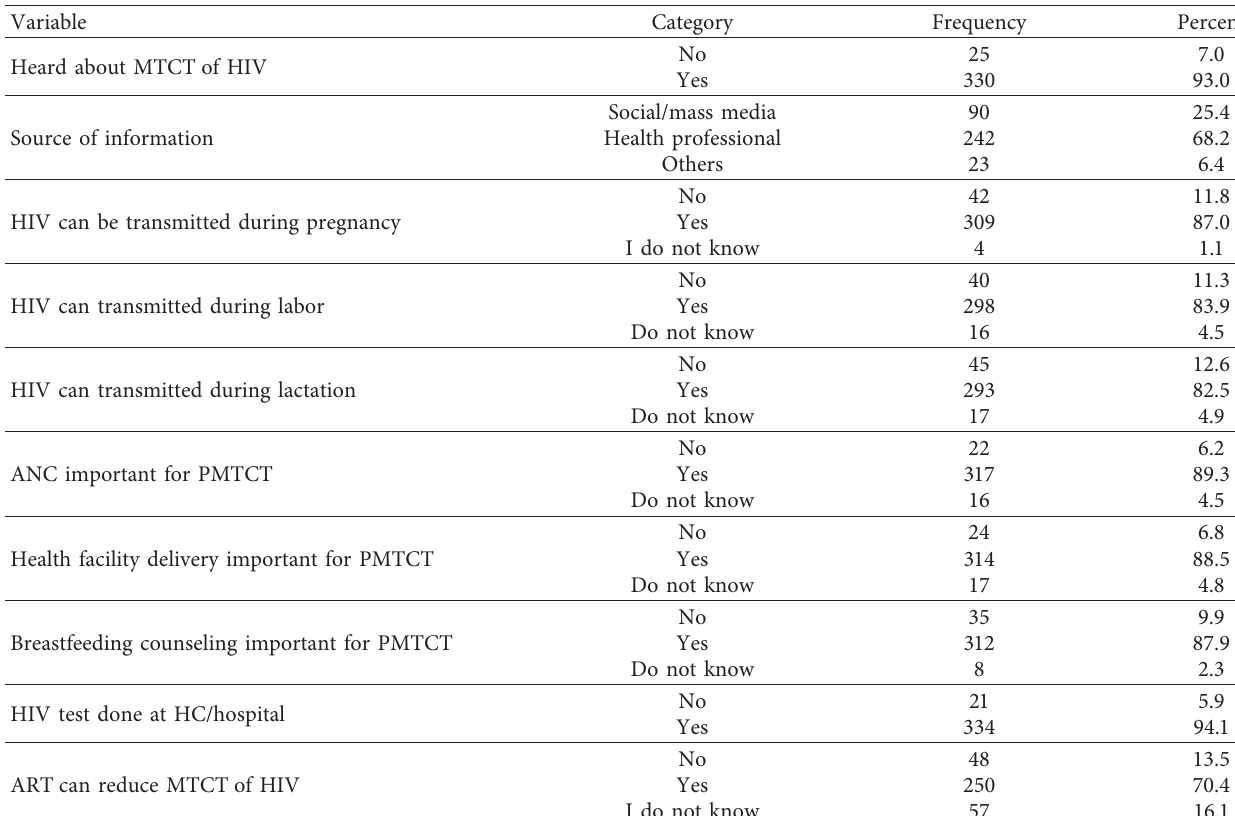
Table 3: Knowledge-related factors among pregnant women attending ANC at public health facilities, Debre Berhan Town, June 2019 ( N �